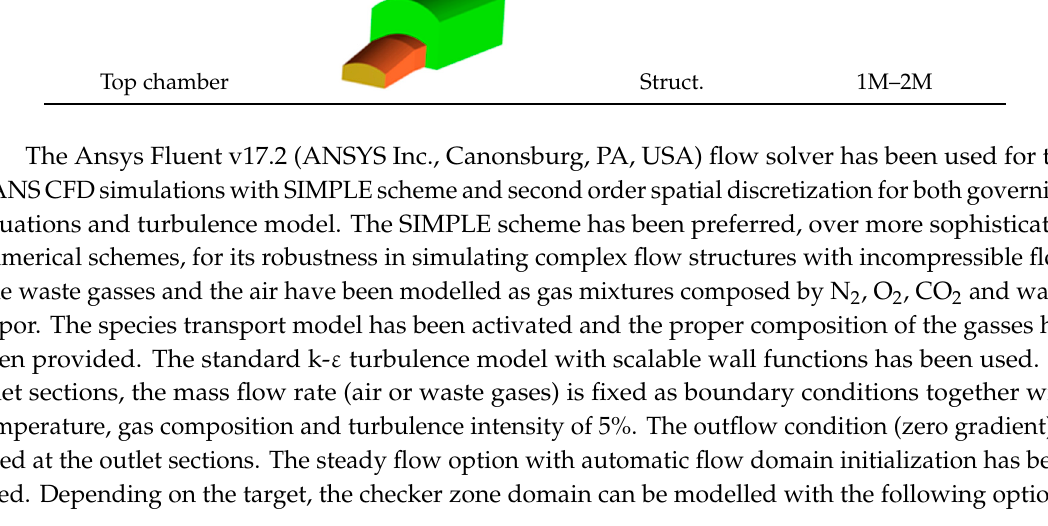
Table 2. Subdomains and mesh characteristics.